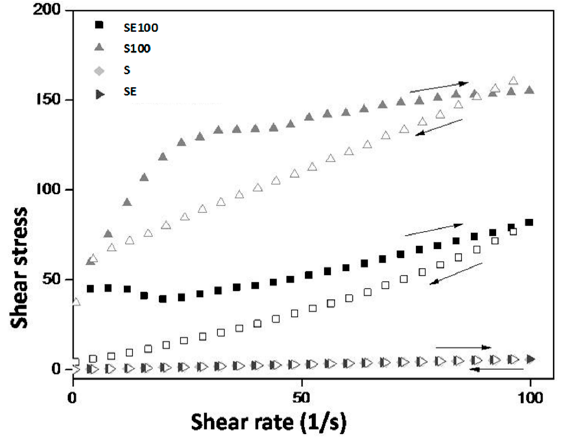
Figure 3. Rheogram of the formulations. Filled symbol upslope and downslope open symbol. Legend: S = Formulation; SE = Formulation with extract; S100 = Formulation + 100% of AVM; SE100 = Formulation with extract + 100% of AVM; Up Arrow = ascending; Down Arrow = descending.